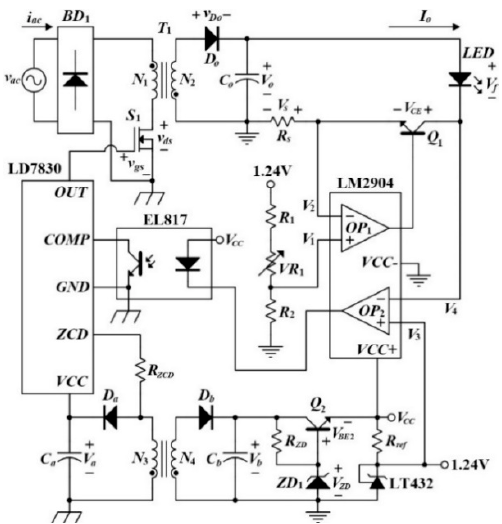
Figure 6. Actual system circuit of the proposed LED driver.